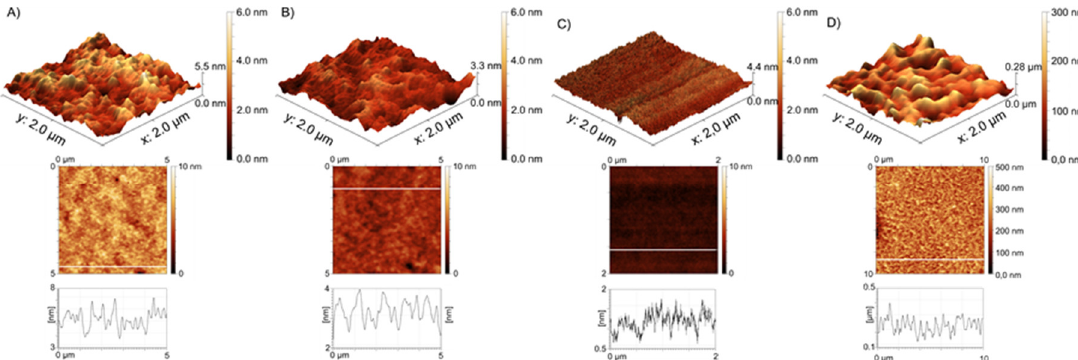
Figure 2. 3D AFM topographic views (top row), height images (middle row), and example height profiles (bottom) of ( A ) Brush1 (R a = 0.3 nm; R z = 1.64 nm); ( B ) Brush2 (R a = 0.12 nm; R z = 0.61 nm); ( C ) Brush3 with a thickness of 30 nm (R a = 0.12 nm; R z = 0.69 nm); and ( D ) Brush3 with a thickness of 300 nm (R a = 26 nm; R z = 154 nm). A detailed analysis can be found in the supporting information.